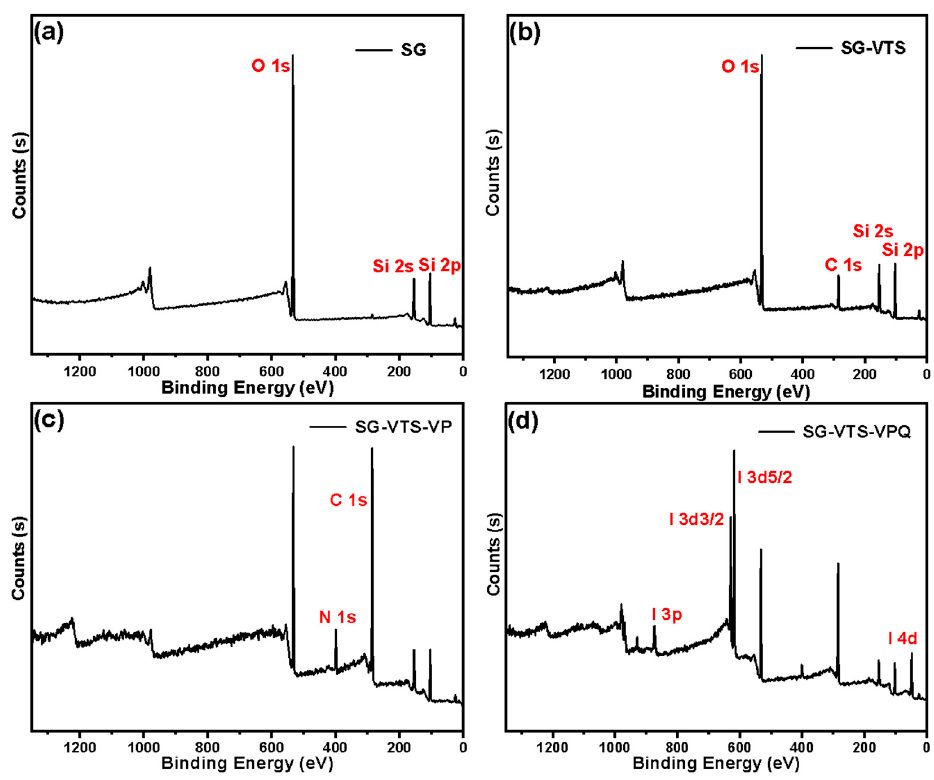
Figure 7. XPS spectra of SG ( a ), SG-VTS ( b ), SG-VTS-VP ( c ), and SG-VTS-VPQ ( d ).